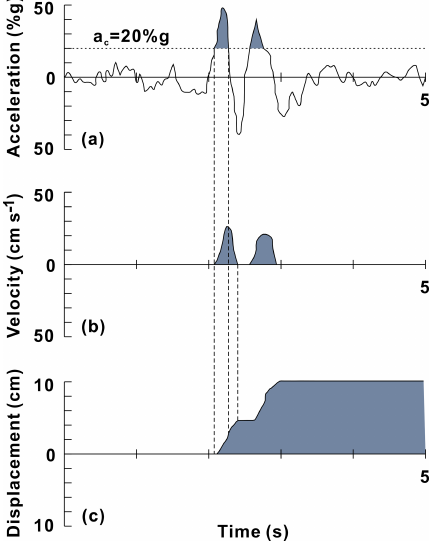
Figure 5. Demonstration of the Newmark analysis